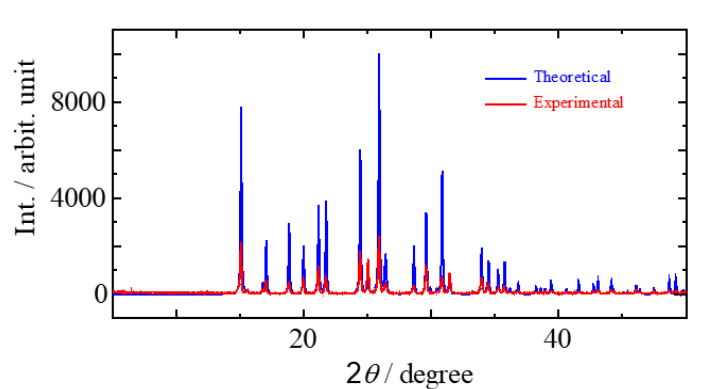
Figure 1. Hydrogen-bonded molecular chain of 5,6-dichloro-2-methylbenzimidazole (DC-MBI).